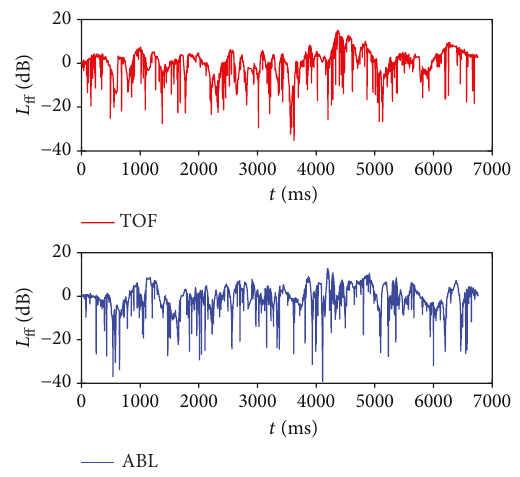
Figure 6: Magnitude of fast fading ( L con fi guration of the Rx antenna